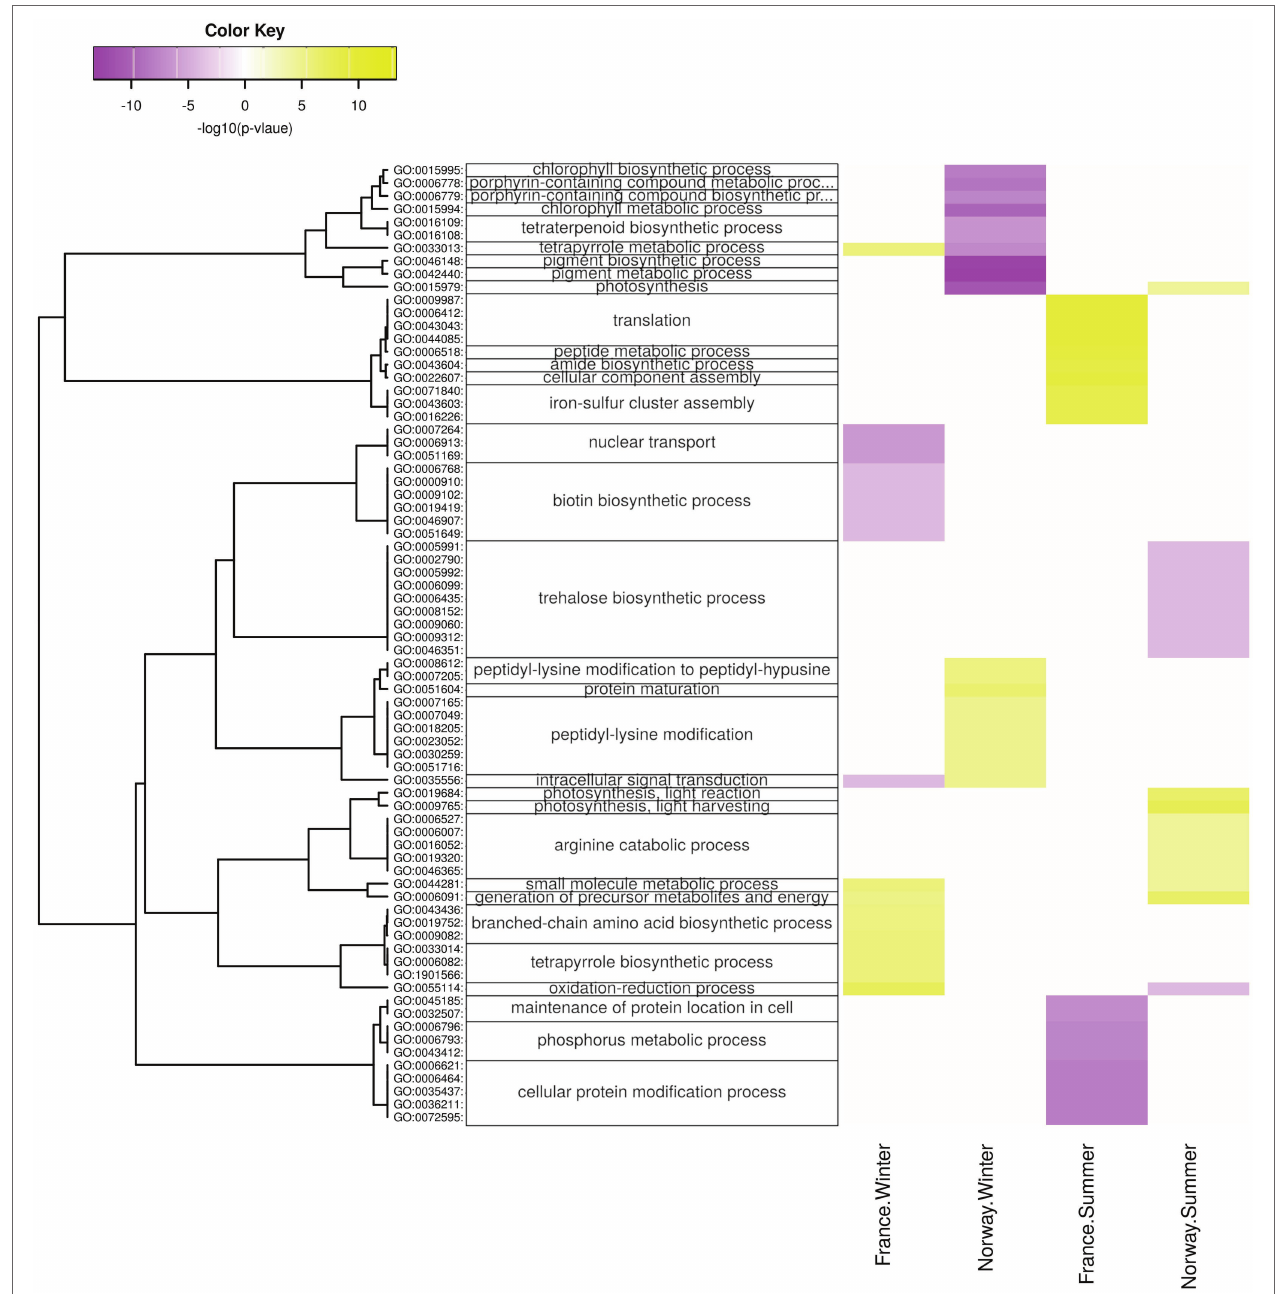
FIGURE 7 | Diurnal changes in biological processes. Enriched processes are shown for each population x season with positive-log10 ( p ) for genes upregulated at day (yellow) and with negative-log10 ( p ) for genes upregulated at night (violet). The hierarchical cluster of GO terms is based on Euclidean distance and a ward.D2 clustering algorithm (Ward’s minimum variance